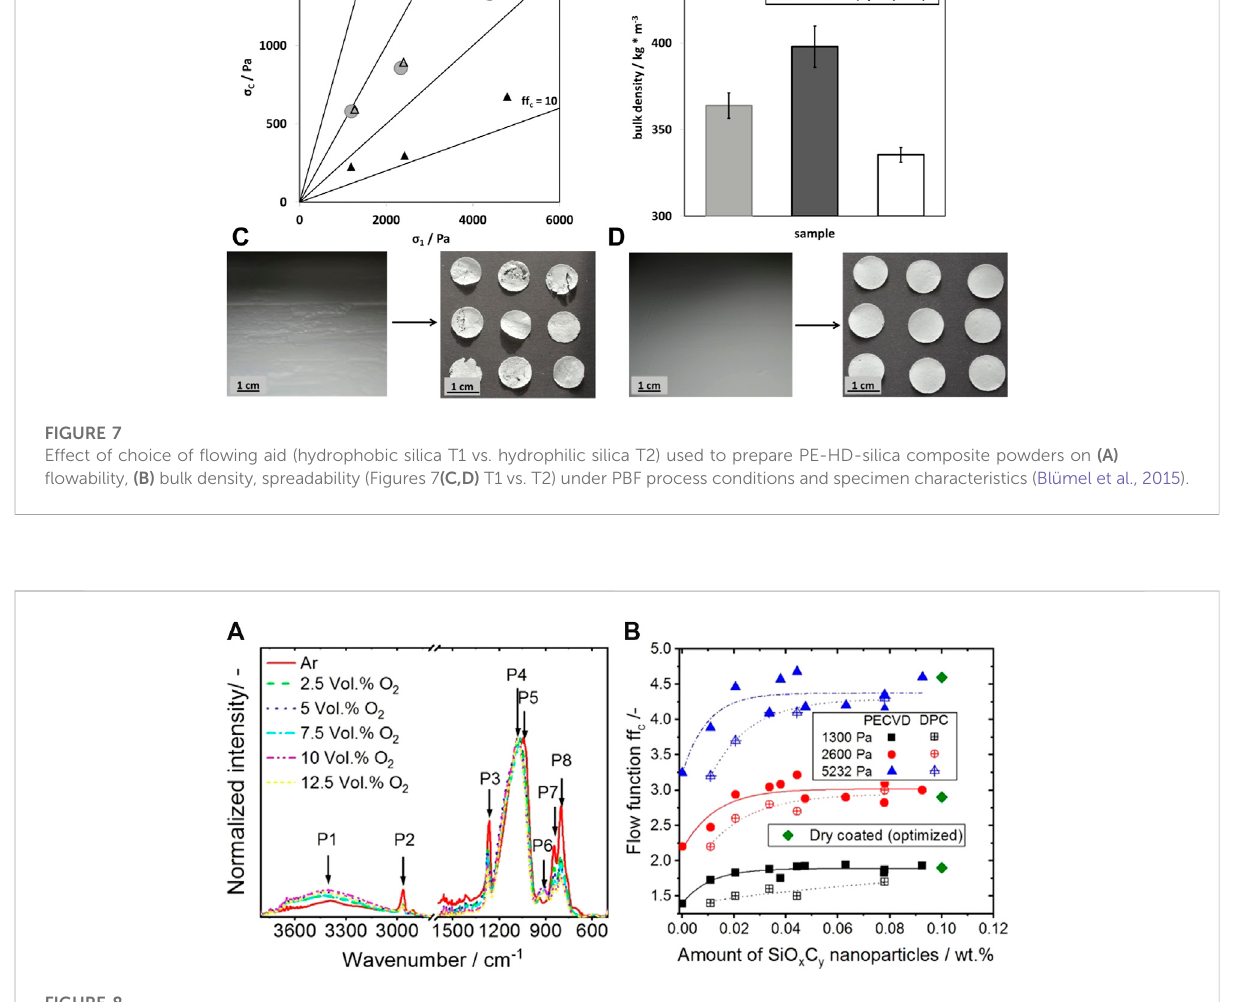
FIGURE 8 (A) : Tuning hydrophobicity of in-situ produced silica nanoparticles by choice of process gas composition (oxygen content) in PECVD functionalization of PP particles in a fl uidized bed. (B) comparison of fl owability of fl uidized bed coated PP and PP particles obtained by dry particle coating (DPC) in a tumbling mixer in dependence on additive content: fl uidized bed coating with in-situ produced silica nanoparticles allows for more improved coatings and, thus, lower additive content necessary to achieve a certain fl ow function ffc (reproduced from Gómez Bonilla et al. (2021a) under the CC BY-NC-ND 4.0